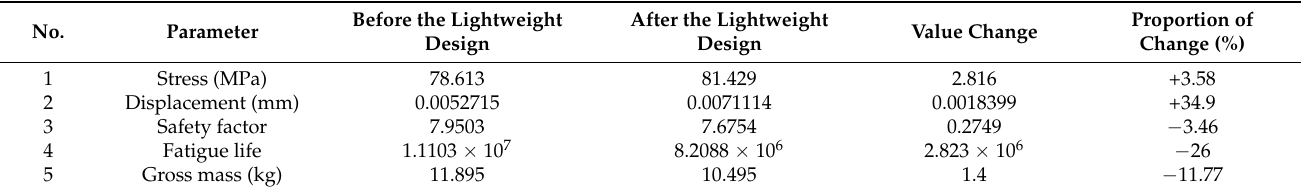
Table 2. Comparison of the mechanical properties of the wheel hub before and after the lightweight